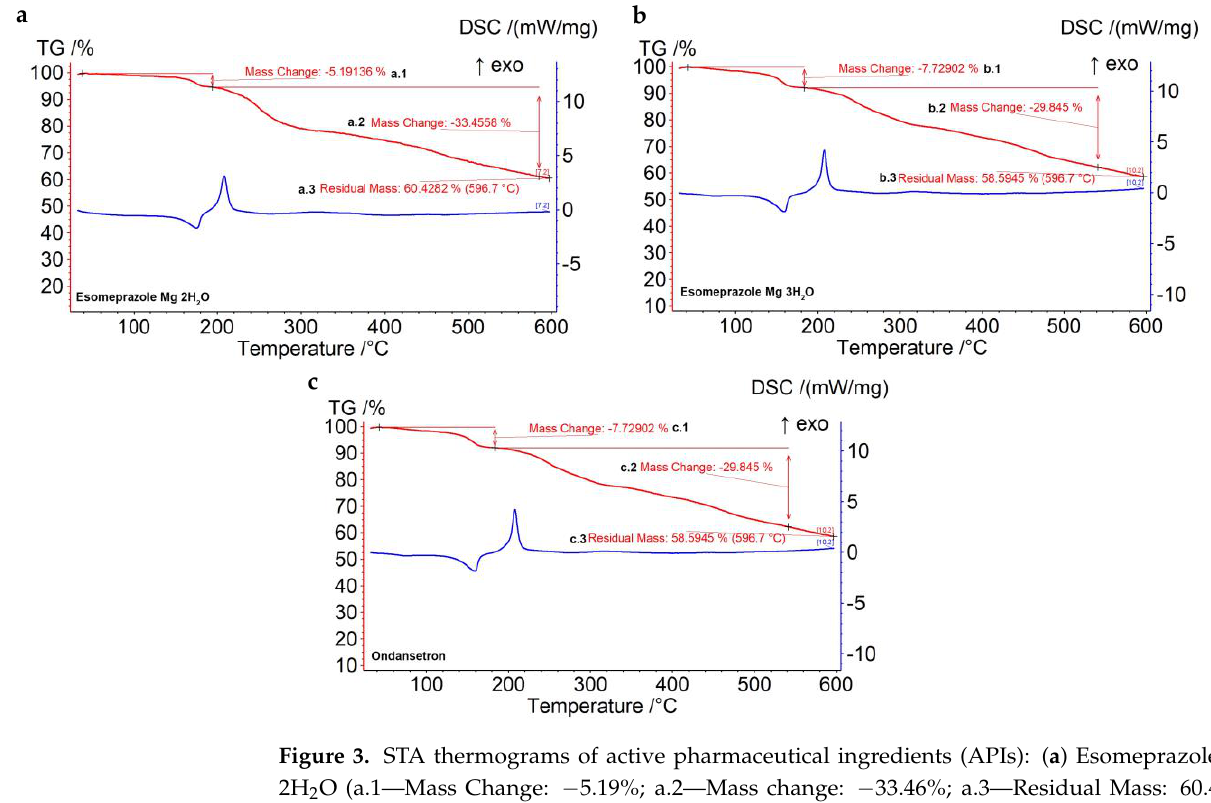
Table 3. Melting temperature and thermal stability of raw materials as determined by STA